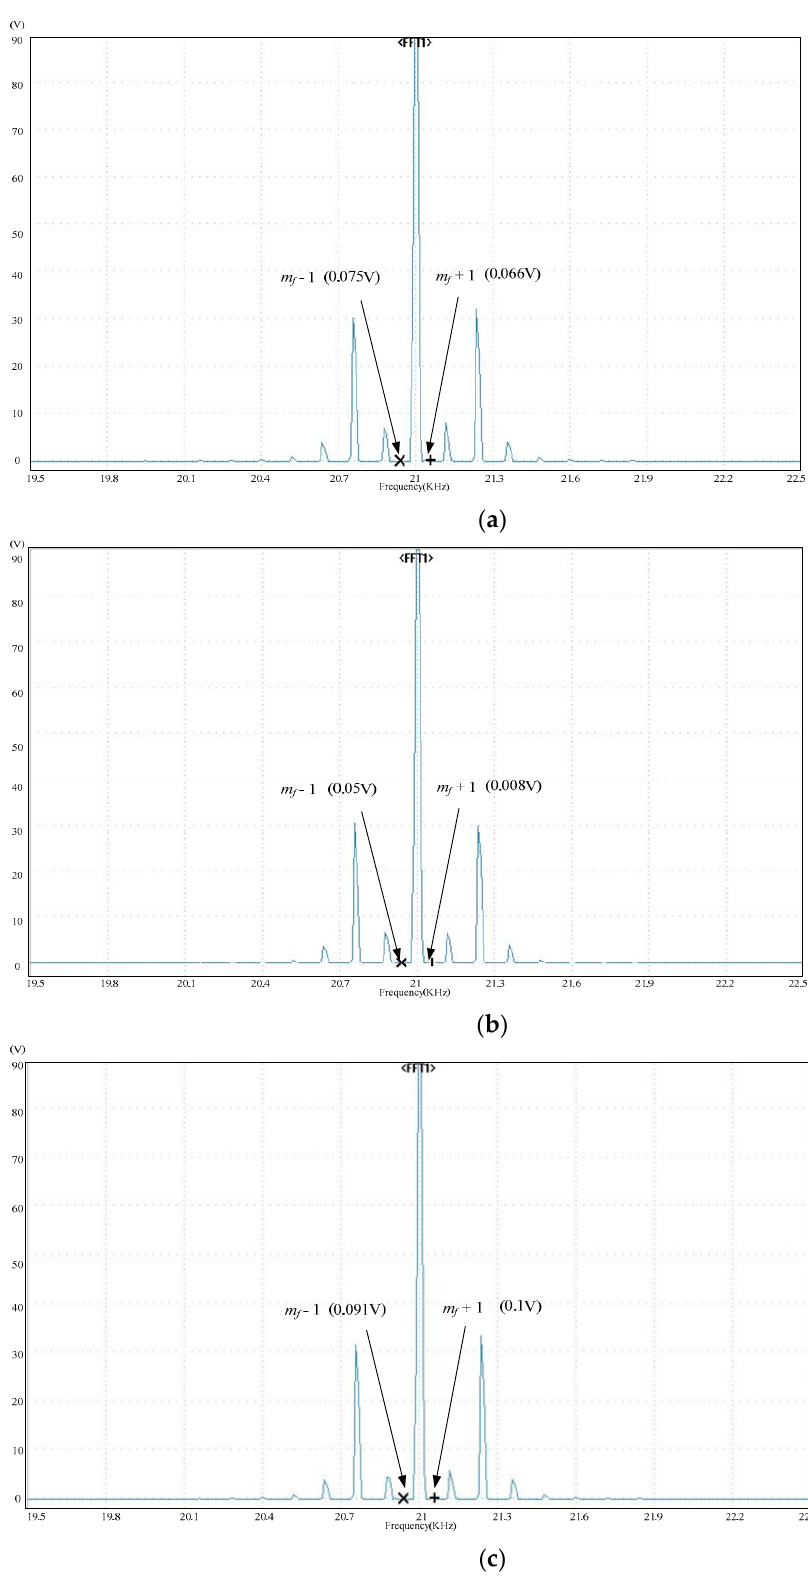
Figure 5. The frequency spectra of the various phase voltages of the inverter at a working frequency of 60 Hz with no switch faults: ( a ) phase voltage v ao ; ( b ) phase voltage v bo ; ( c ) phase voltage v co .